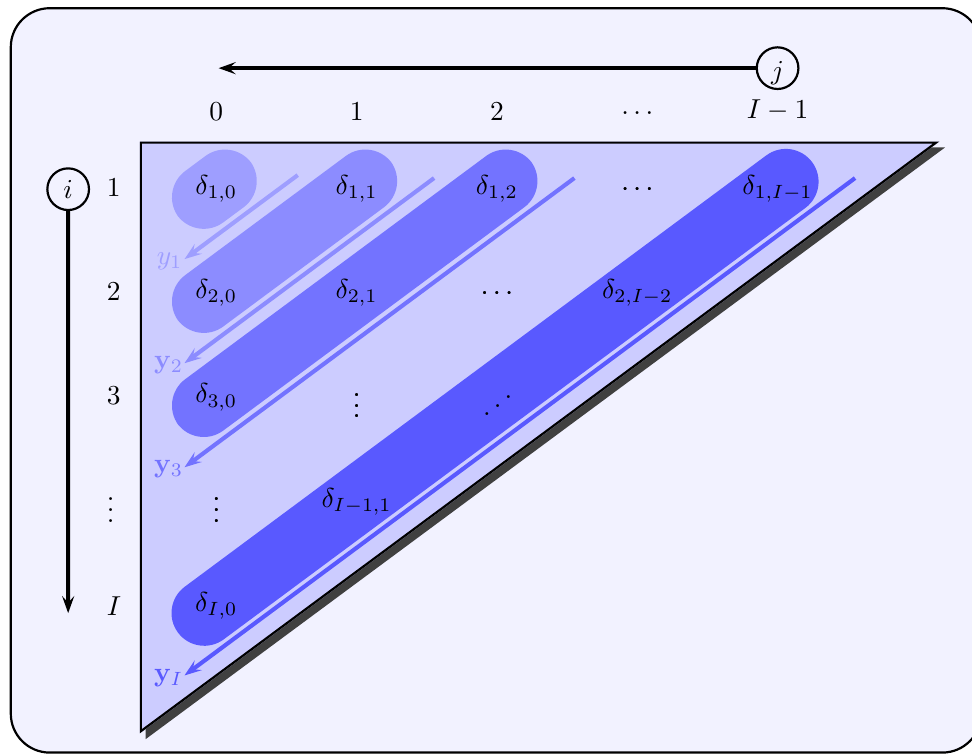
Figure 7. Modeling of the observation vector in De Jong